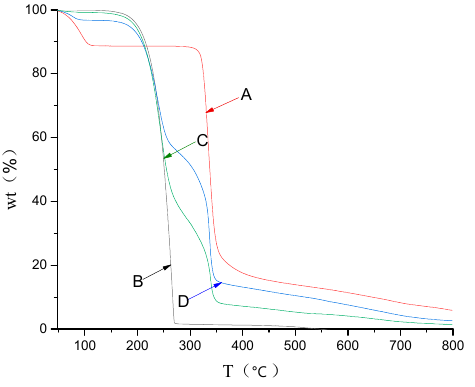
Figure 8. Thermogravimetric analysis (TGA) results: ( A ) β -CD; ( B ) diuron; ( C ) physical mixture; and ( D ) the inclusion complex.